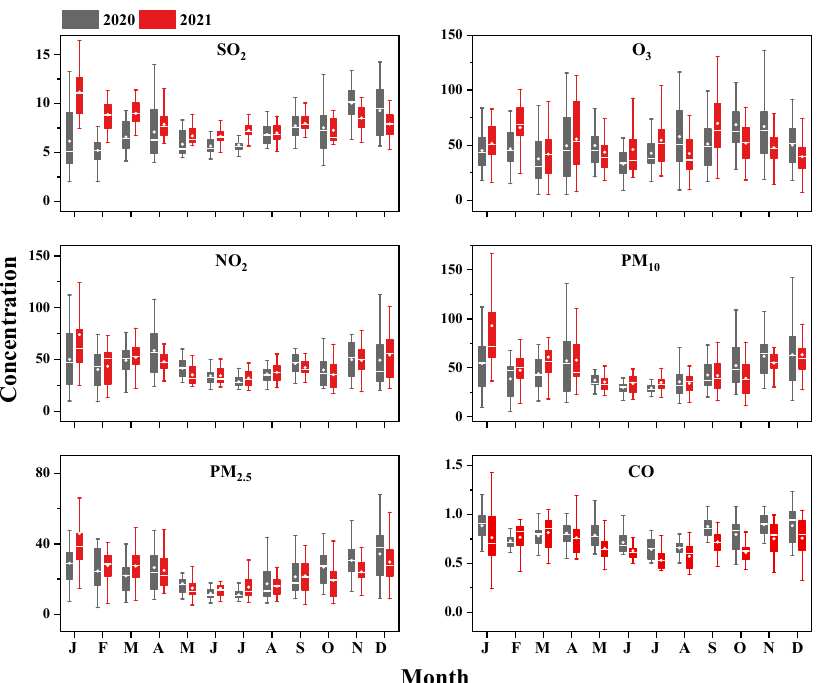
Figure 3. Boxplots of the monthly mean changes in the concentrations of six types of pollutants, SO 2 , O 3 , NO 2 , PM 10 , CO, and PM 2.5 , from 2020 to 2021. The units of the CO concentration are mg/m 3 , and the units of the concentrations of the other pollutants are µg/m 3 . The black boxes represent 2020 and the red boxes represent 2021.